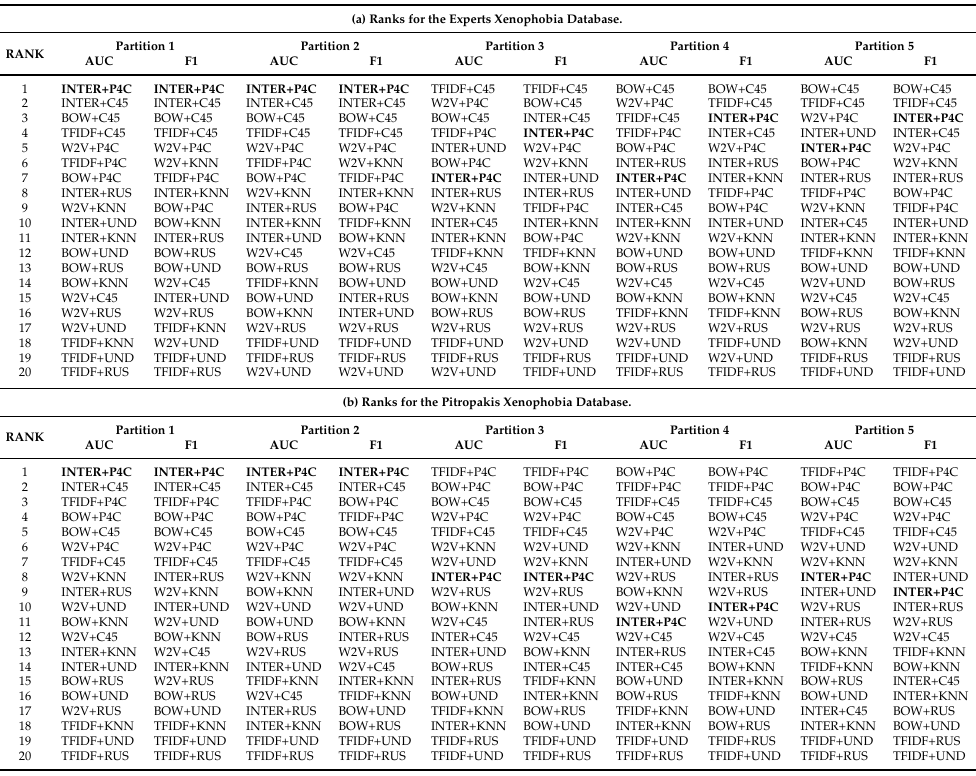
Table 11. Ranking of the AUC and F1 score metrics. Each cell represents the combination of an embedding method jointly with a classifier. The best interpretable combination is INTER+P4C